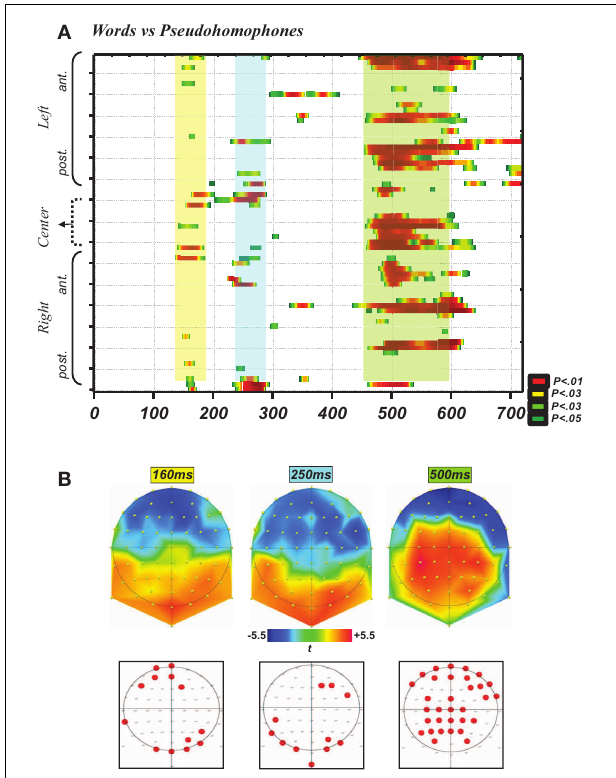
FIGURE 1 | (A) Graph depicting the statistical p -values (yellow-green for p < 0 . 05; dark red for p < 0 . 01 and highest values) of the exploratory point-wise t -tests analysis (see Methods) performed on all time points from 0 to 700ms (i.e., 358 time frames, x -axis) and all 64 recording sites ( y -axis) for the comparisons words vs. PHw. This analysis showed that robust (highest p -values) and consistent (longest in duration and implying many electrodes) differences appeared already in the N170 time window, then at ∼ 250ms (i.e., P2 component) and then around the P600 component. (B) This panel illustrates t -maps (upper raw) successively for the time periods at 160, 250, and 500ms (see the same color scale for t -values). The lower raw presents on schematic maps the location of the electrodes depicting significant differences during these time points, and shows that during the N170 there were six adjacent posterior and six anterior sites with significant p -values (lower left) and in the other periods there was also a high number of significant and adjacent electrodes.